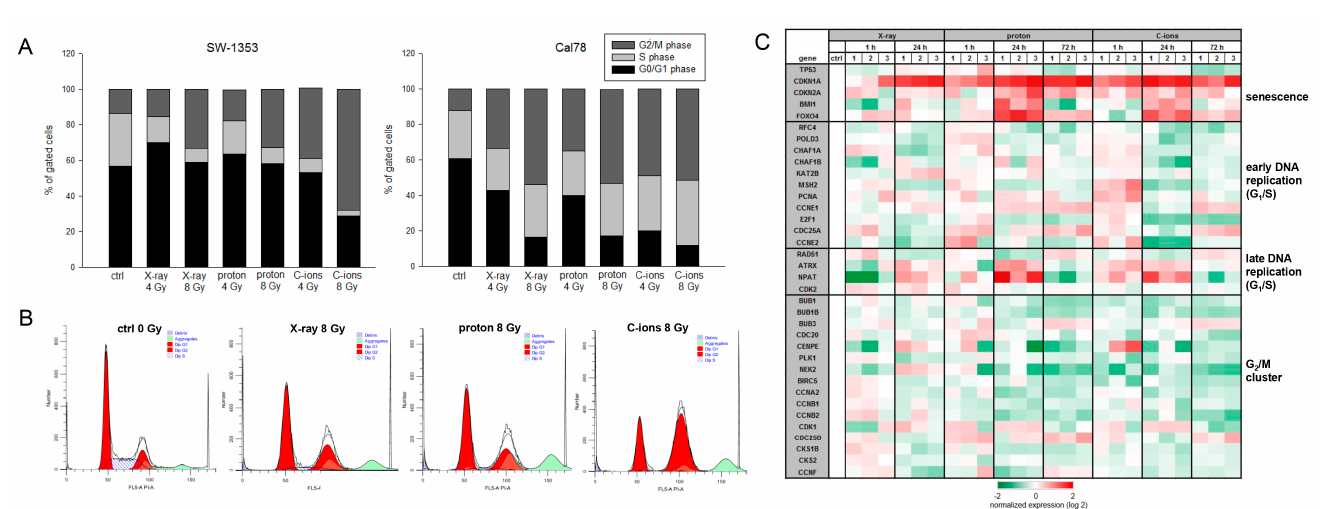
transformed fold-change regarding expression of cell cycle regulation genes alterations after IR (Figure 4C). Particularly prominent, senescence genes such as CDKN1A (p21), CDKN2A (p16NK4a), BMI1, and FOXO4 were upregulated after particle IR. The early DNA replication genes PCNA, MSH2, CDC25A, and CCNE2 were especially increased at the 1 h time point, whereas the late replication genes NPAT and ATXR peaked 24 h after sponding genes could be observed.